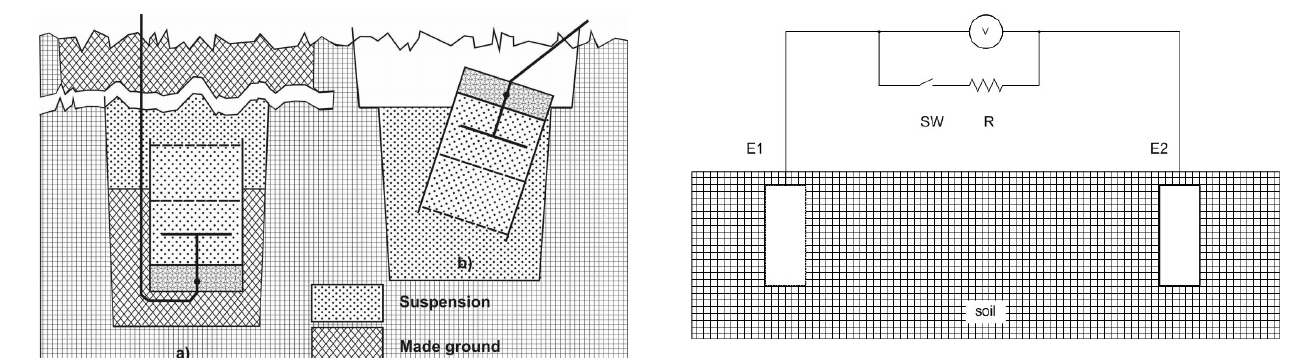
Figure 6. Electrode resistance measurement